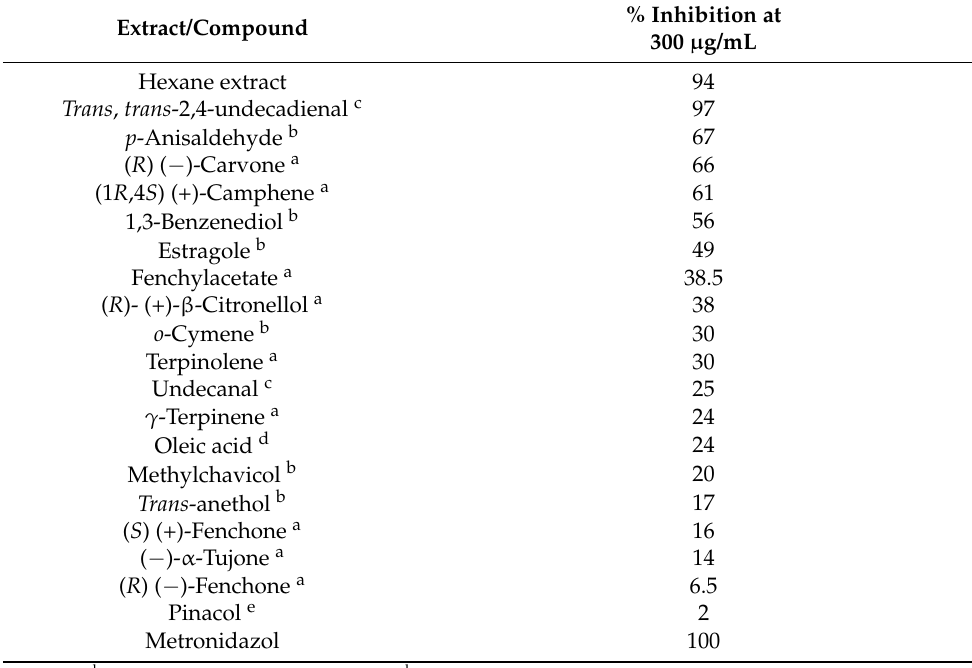
% Inhibition at 300 µ g/mL